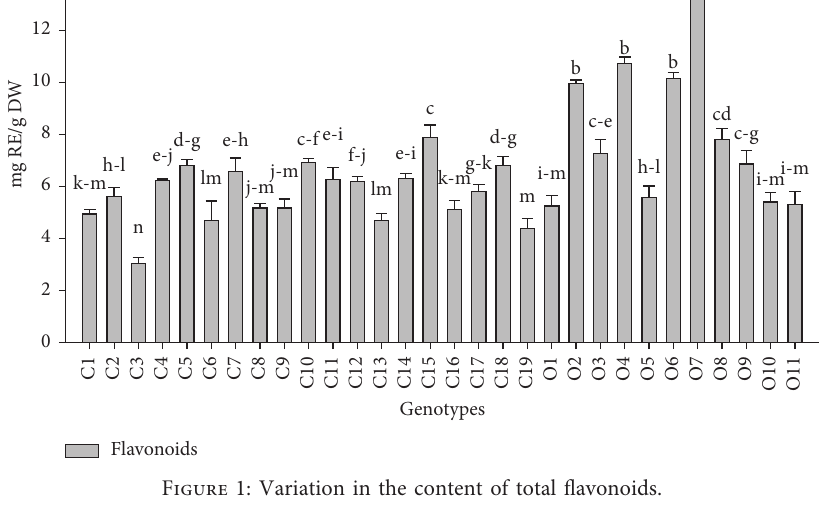
Figure 1: Variation in the content of total flavonoids.